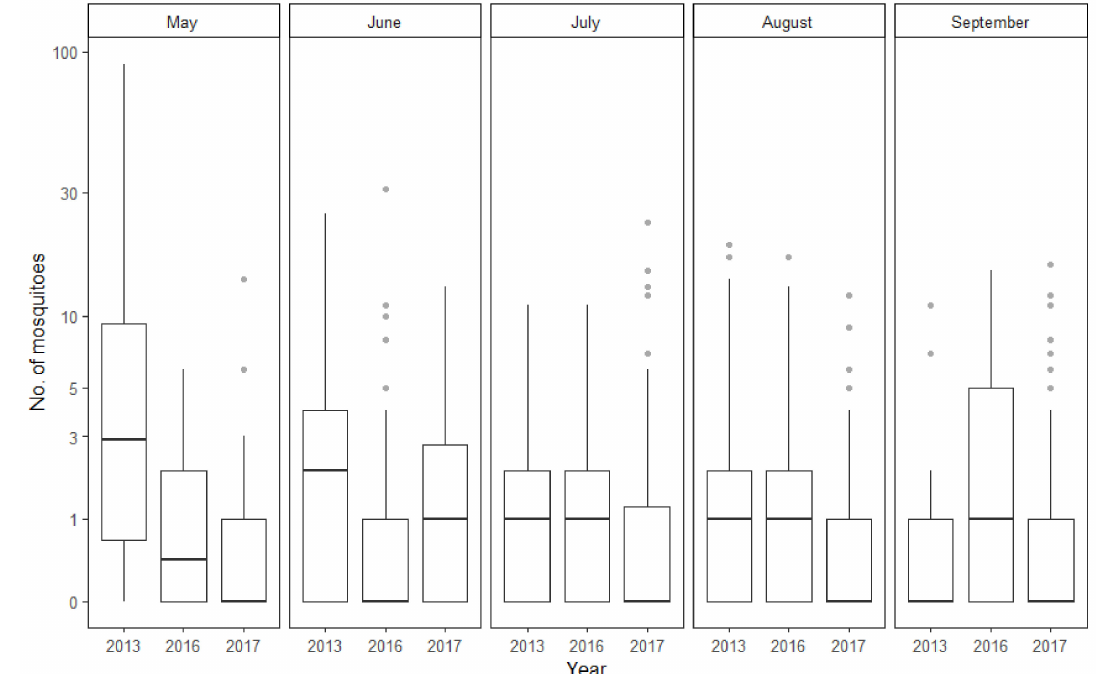
Figure 2. Average number of mosquitoes collected during the different months of the study period. Boxplots showing the median (dark line dividing the box), interquartile range (IQR) containing 50% of the data points (length of the box), upper and lower quartiles (whiskers) and outliers (gray dots). Y -axis has been transformed to a logarithmic scale for ease of